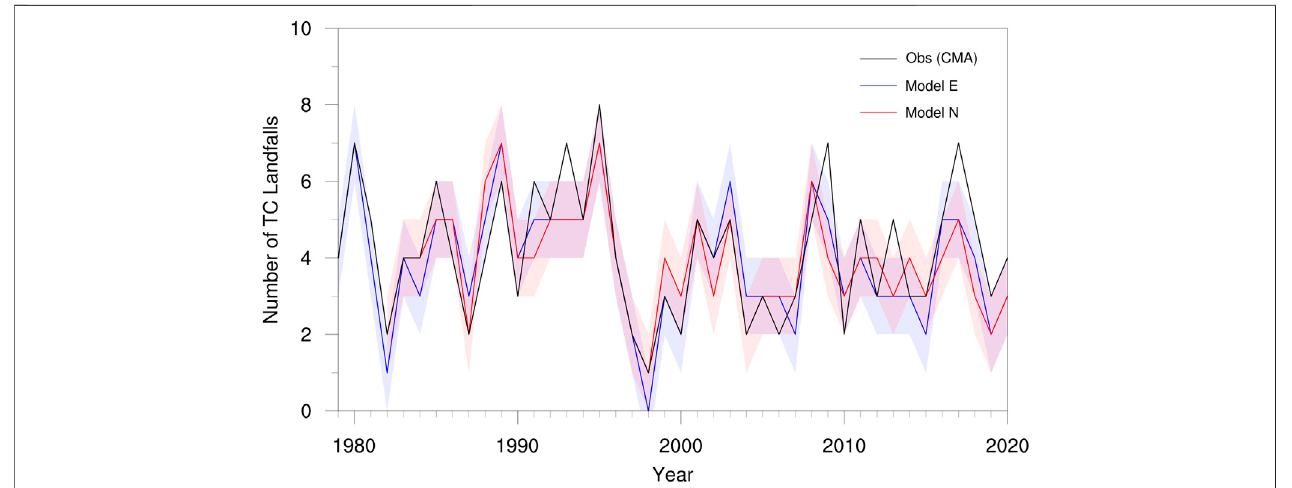
FIGURE 7 | Time series of the observed (black line) and modeled TC landfalls on South China based on the ECMWF (Model E; blue line) and NOAA (Model N; red line)data.The blueand red shadings indicatethe modeluncertainties(denotedby ± 1ofcorrespondingRMSEin ModelEand ModelN, and thenrounded tothe nearest integers, respectively). Note that the modeled results before 2006 are based on the model training, those after are for the model validation.